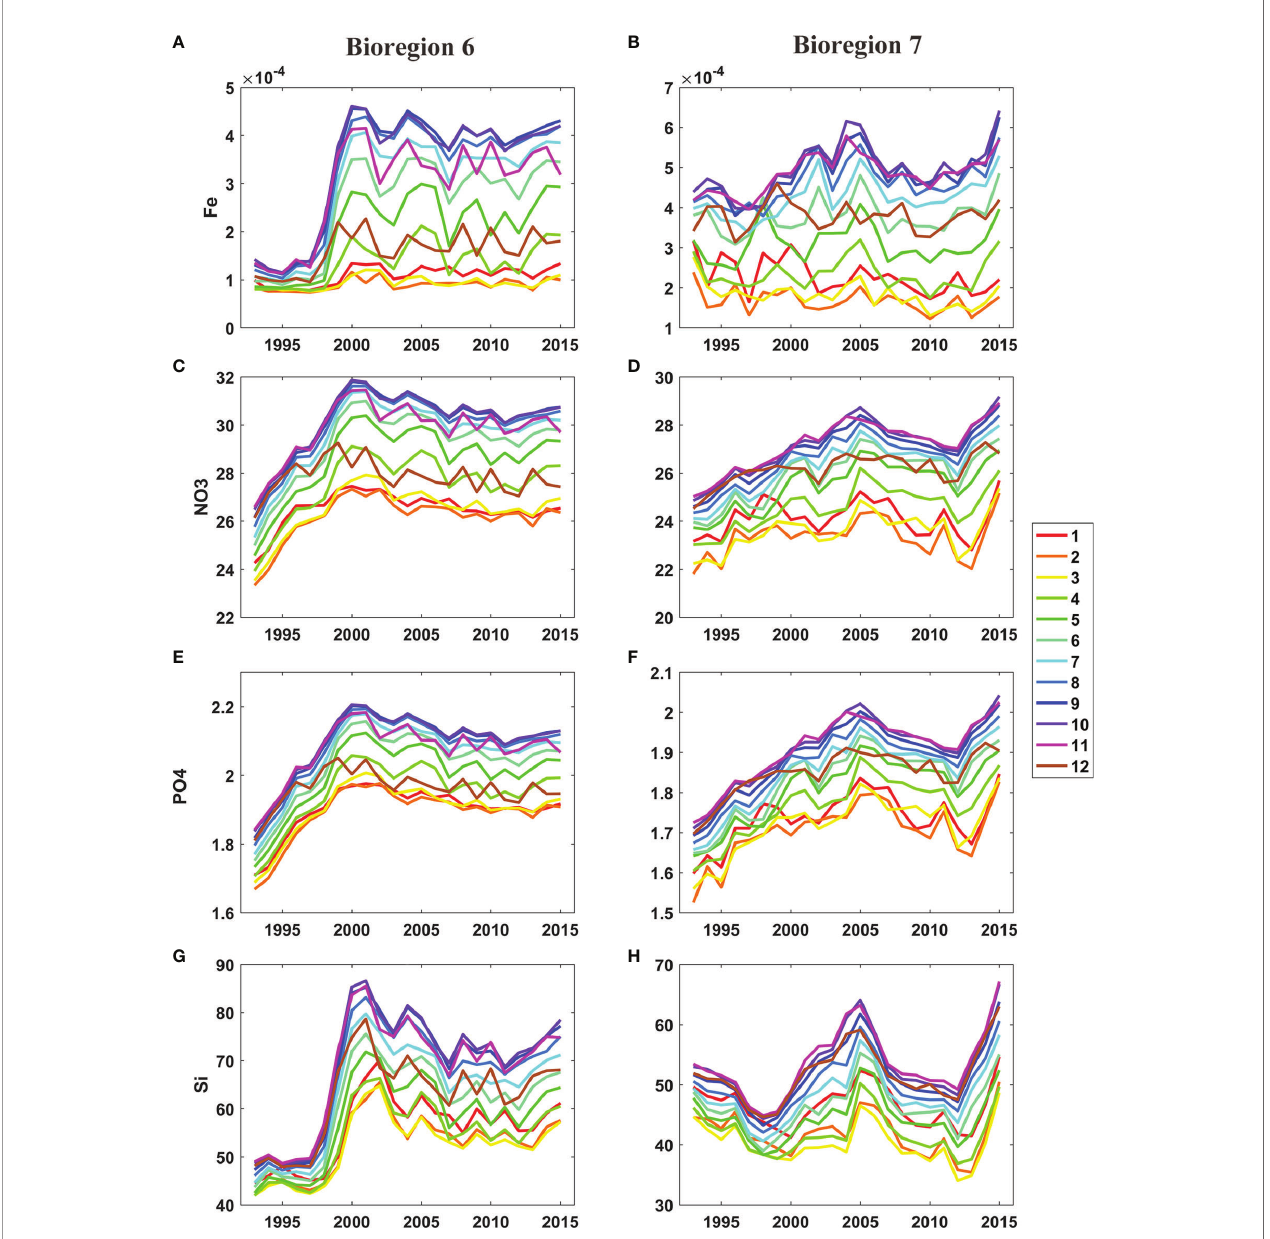
FIGURE 9 | Changes in monthly Fe (A, B) (mmol m -3 ), monthly nitrate (C, D) (mmol m -3 ), month phosphate (E, F) (mmol m -3 ) and monthly silicate (G, H) (mmol m -3 ) in bioregion 6 (left panels) and 7 (right